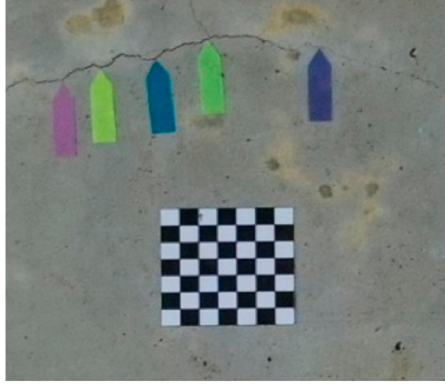
Figure 12. Planar marker.